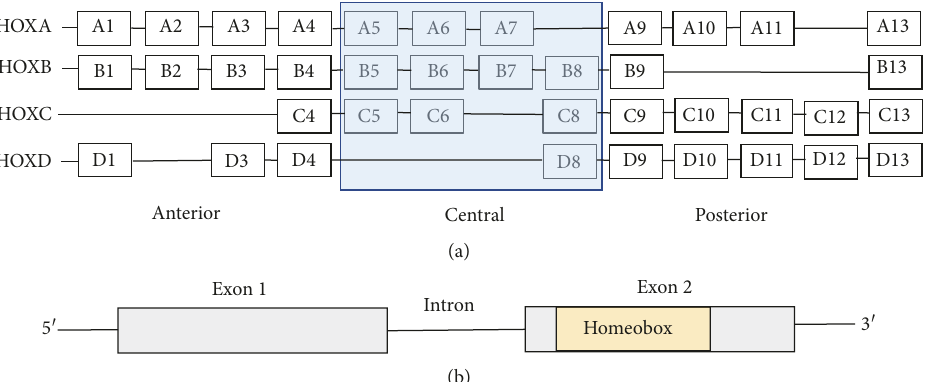
Figure 1: HOX genes and genome organization. (a) In humans, there are a total of 39, clustered into four families, namely, HOXA, HOXB, HOXC, and HOXD. Each family consists of 13 paralogous groups with nine to eleven numbers assigned based on their sequence similarity and position within the cluster. (b) HOX genes have two exons and 1 intron. Exon 2 has a 120-nucleotide sequence, called a Homeobox that encodes a 61 amino acid HOX